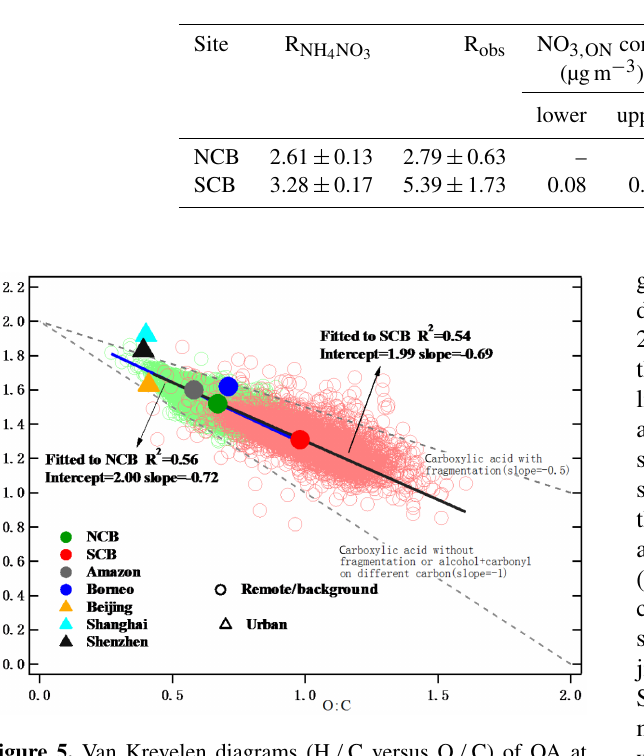
Table 2. Results of organic nitrates estimated using the NO + x ratio method.